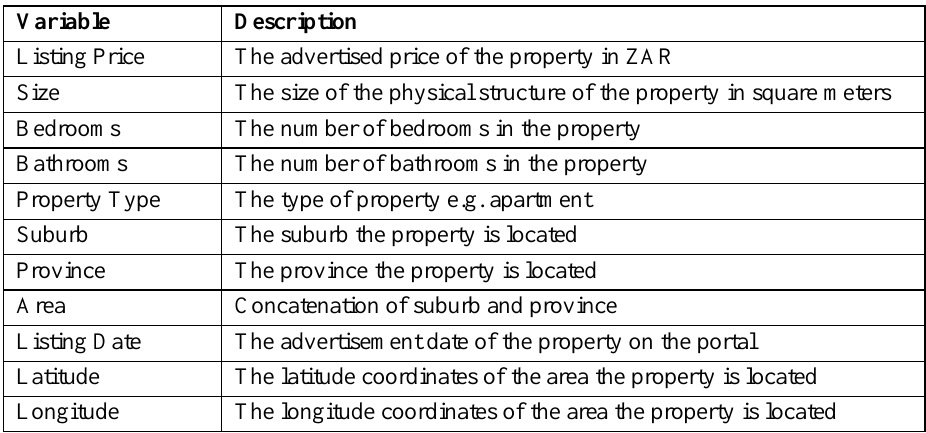
Table 1: Description of the Data